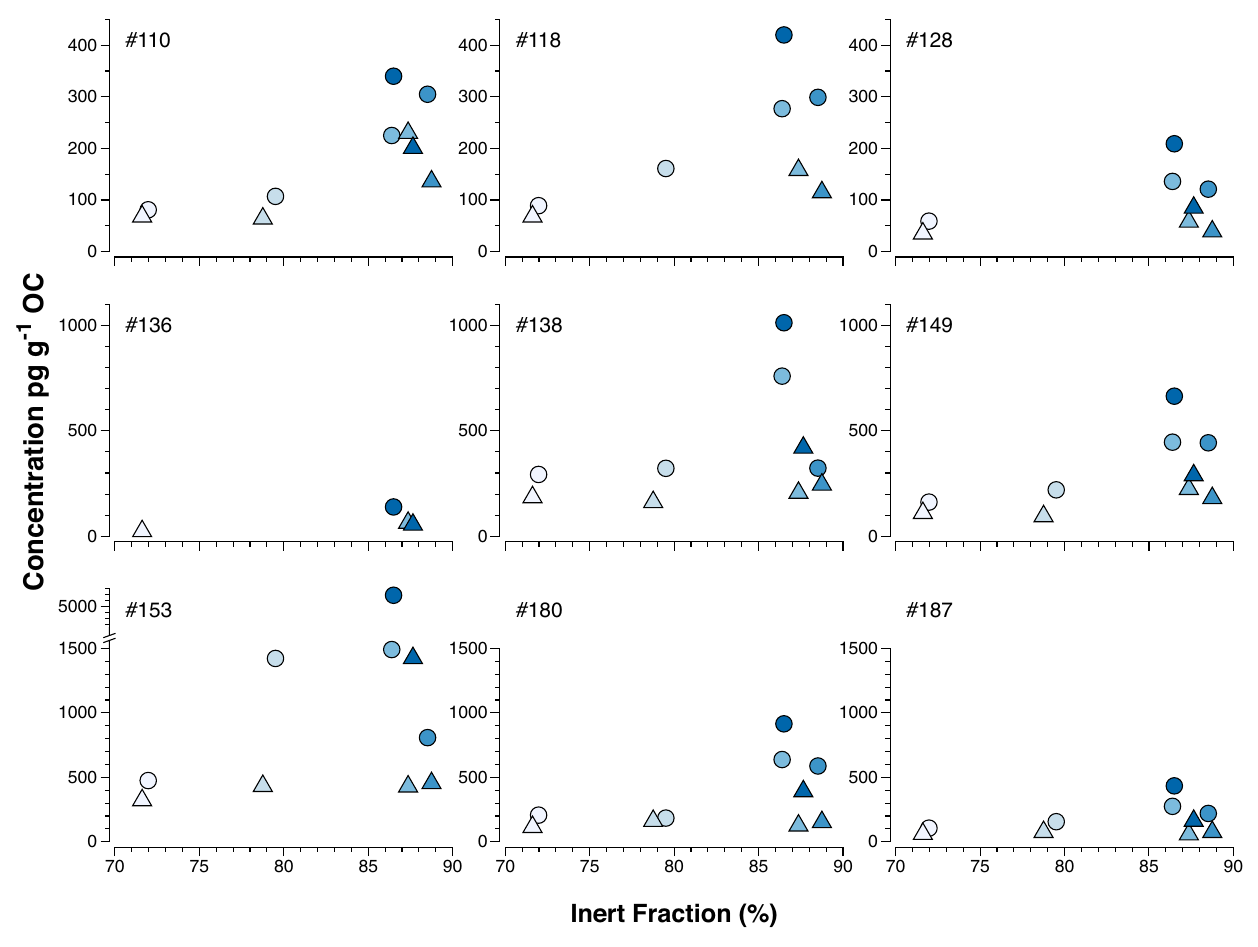
NGOC/TOC). Sediment concentrations in layer 0 – 20mm are depicted by circles and in layer 20 – 40mm by triangles. Colors from bright to dark indicate water depth from shallow to